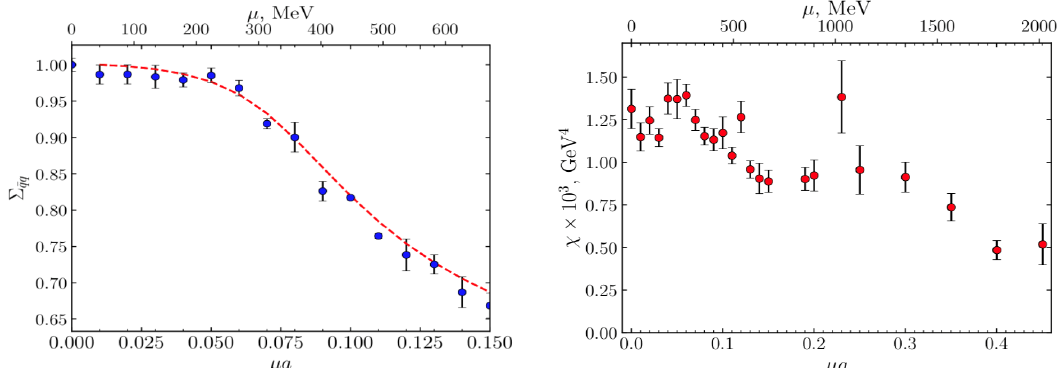
Figure 7. Chiral condensate and topological susceptibility as a function of baryochemical potential in two-color QCD, from Ref. [34].